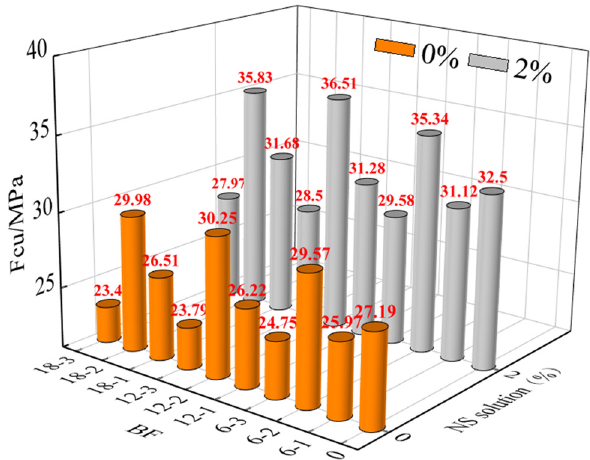
Figure 9: The synergistic e ff ect of NS and BF on the compressive strength of